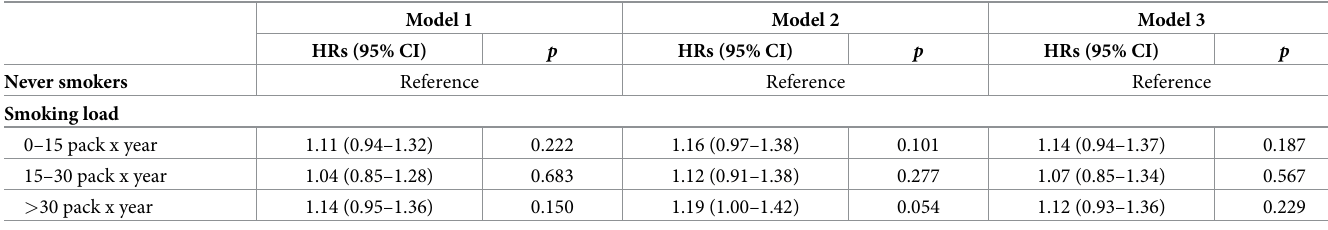
Table 3. Hazard ratios for incident CKD according to smoking